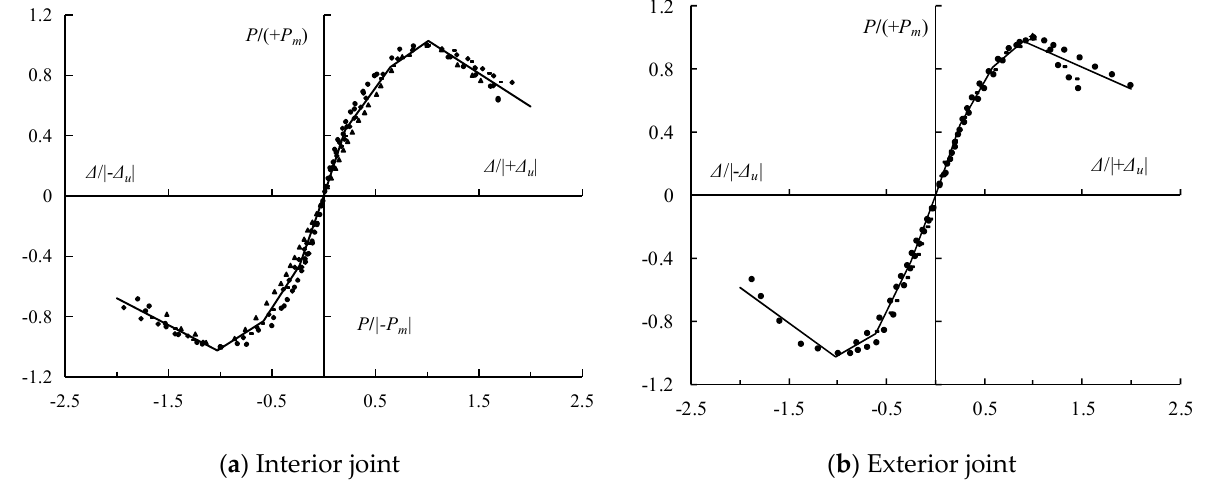
Figure 20. Dimensionless skeleton curve.